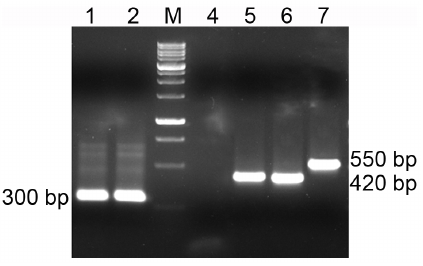
Figure 5. Analysis of BoR300 transcription. Total RNA from male (lane 1) and female (lane 2) adult B. oleae flies were extracted and reverse-transcribed using random oligonucleotides. Satellite transcripts were amplified by PCR using BoR300-F and BoR300-R primers. M represents the molecular marker (1000 bp/1 kb BLUE DNA Ladder, GeneON). The epic175F and epic175R primers were also used, to check the presence of any DNA contamination on both male and female cDNAs (lanes 4 & 5 respectively). The amplification results were compared to those obtained using the genomic DNA as template (lane 7) at which the product size was 550 bp.